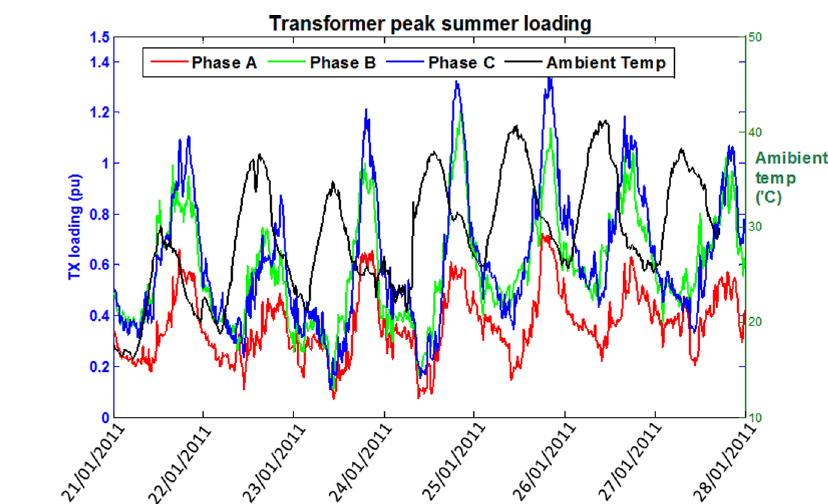
Fig. 2. Distribution transformer peak summer loading, January 21 – 27,